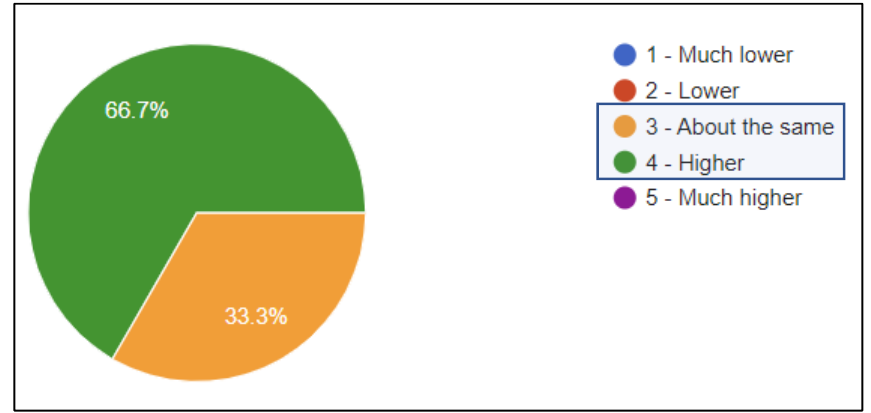
Figure 10. Students’ analysing skills before experiential learning in smart classroom (Subject 1).